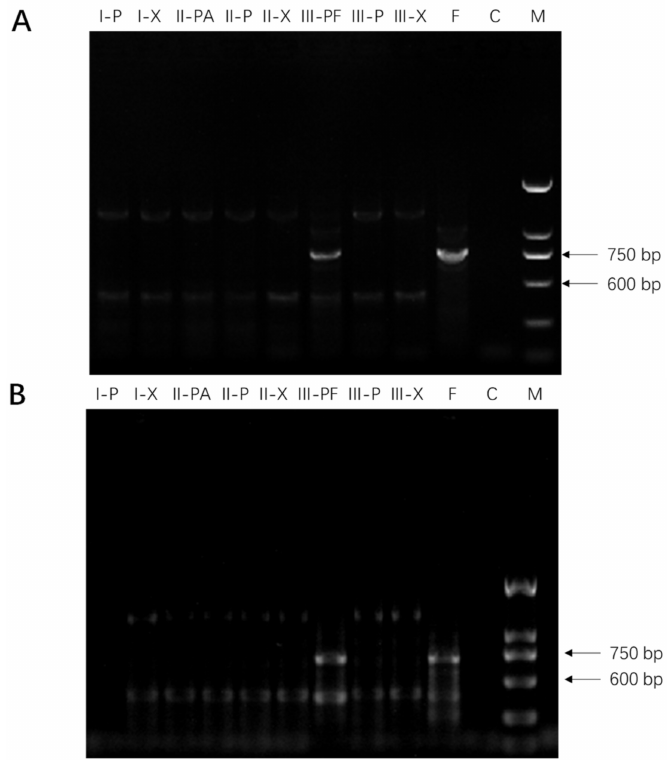
Figure 1. Detection of F. solani (strain F19, panel ( A )) and F. oxysporum (strain C1, panel ( B )) in American ginseng root tissues using polymerase chain reaction (PCR). Gel lanes show the presence of PCR products from left to right: (I-P), phloem of part I; (I-X), xylem of part I; (II-PA), phloem under PDA plugs of part II; (II-P), area adjacent to PDA plugs of part II; (II-X), xylem of part II; (III-PF), phloem under Fusarium culture plug of part III; (III-P), adjacent Fusarium culture plugs of part III; (III-X), xylem of part III; (F), positive control ( Fusarium spp.), (C), negative control (no DNA template), and (M), DNA